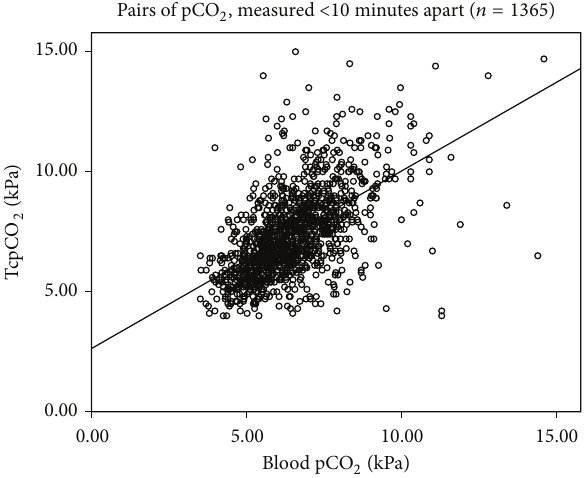
Figure 1: Scatter plot of the blood pCO 2 and the TcpCO 2 of values measured < 10mn. Scatter plot of the blood pCO 2 ( 𝑥 -axis) and the TcpCO 2 ( 𝑦 -axis) of values measured < 10 minutes apart. Values are in kPa. 𝑛 = 1365 . Pearson’s 𝑅 = 0.58 ( 𝑝 < .001 ).